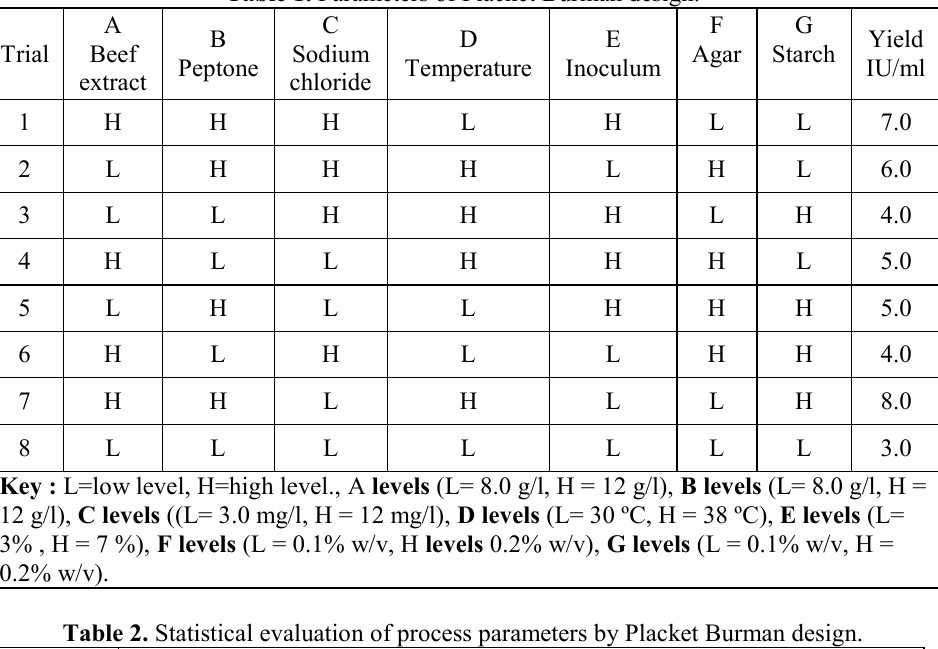
Table 1. Parameters of Placket Burman design.